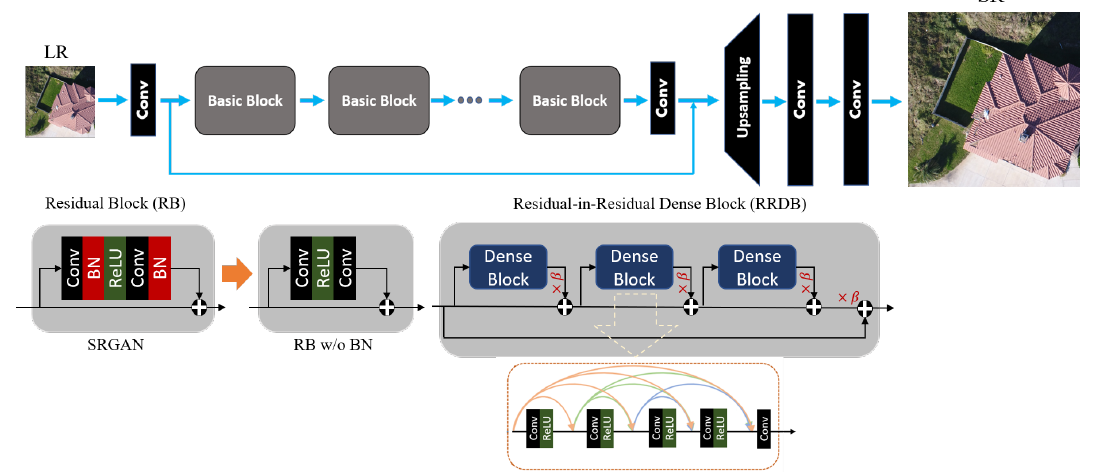
Figure 4. Basic architecture of SRResNet with different possible residual